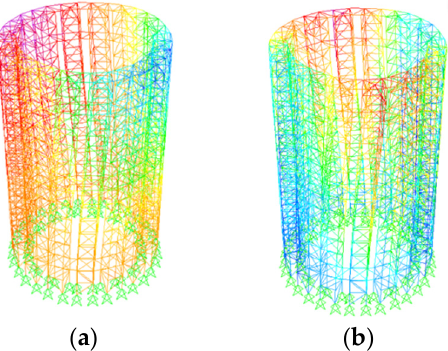
Figure 16. Deformation of an inner ring-supported tire frame (mm) (a ) X-direction, ( b ) Z-direction.